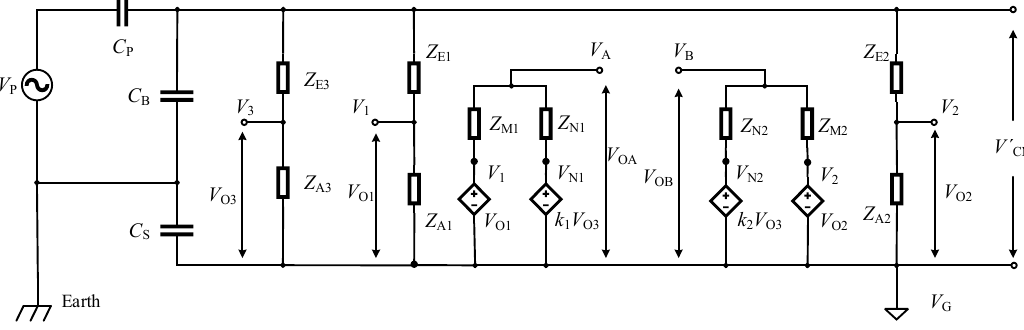
Figure 5. Equivalent circuit model of the dual-electrode bioelectric acquisition equipment for CMI suppression with the proposed noise neutralization method.